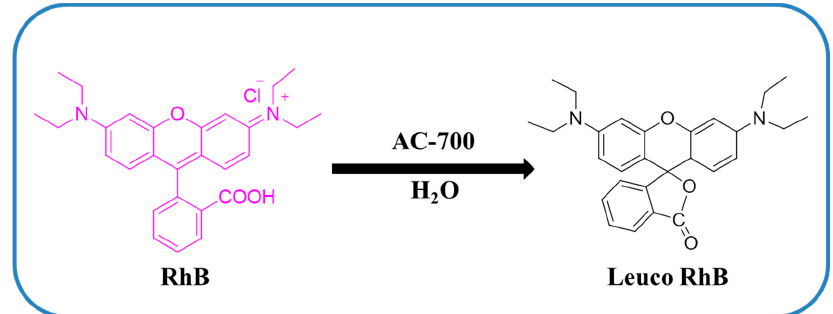
Scheme 3. Degradation mechanism of